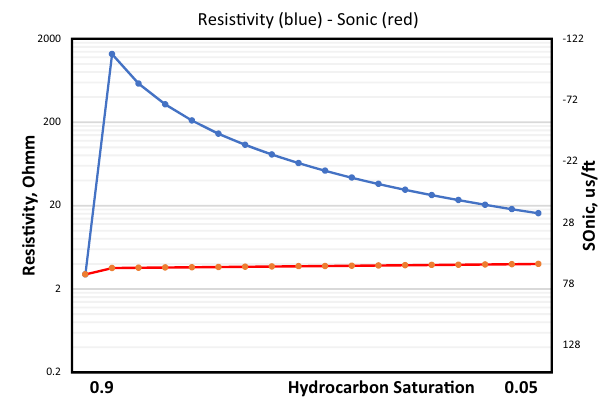
Fig. 5 Sonic–resistivity overlay, V Table 3 Rock responses with, V